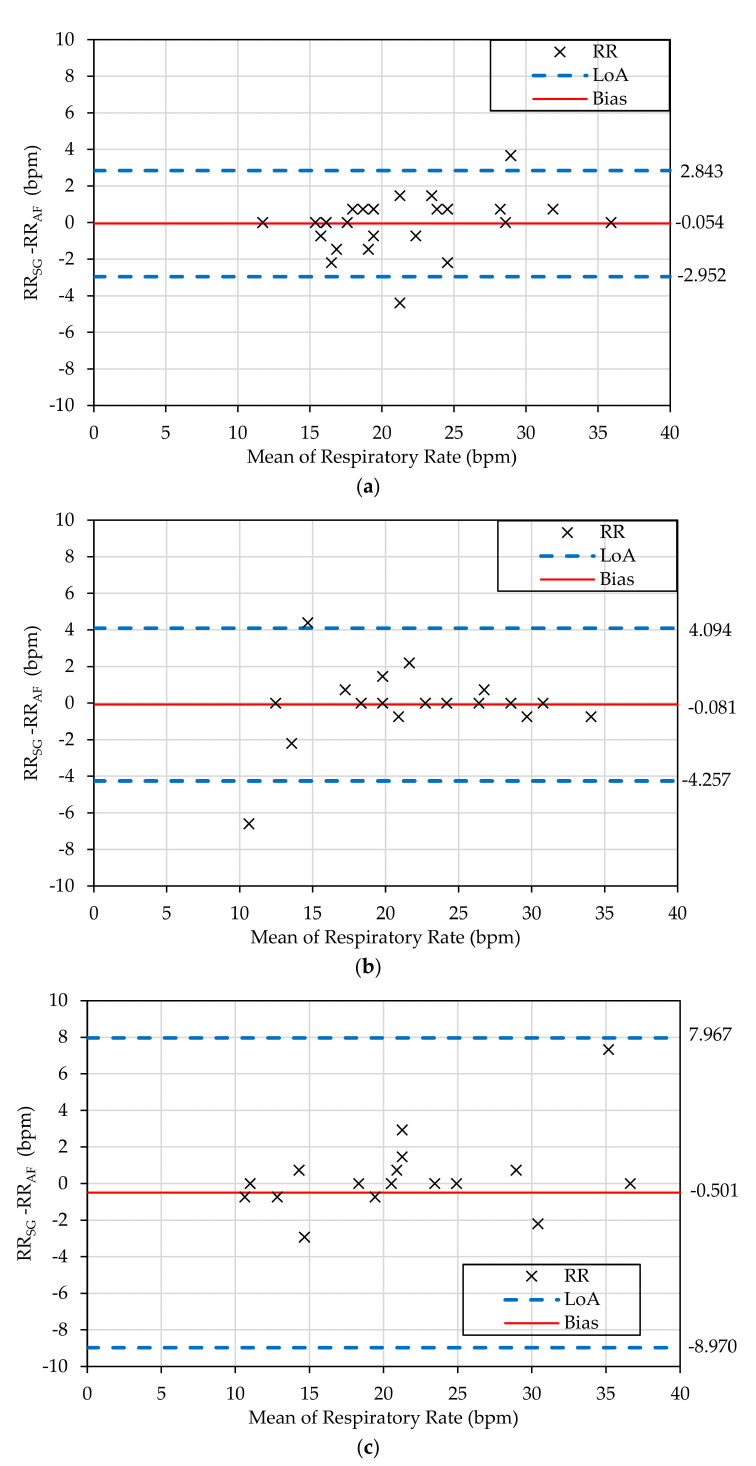
Figure 4. Bland-Altman analysis of the measured respiratory rate of the COPD patients at different postures, namely at ( a ) sitting, ( b ) standing, and ( c ) lying45 ◦ posture. Each cross represents the data point of RR measurement. The continuous red line represents the bias, which is the average difference between the RR AF and the RR SG while the dashed blue lines are the limits of agreement where 95% of the data lies in